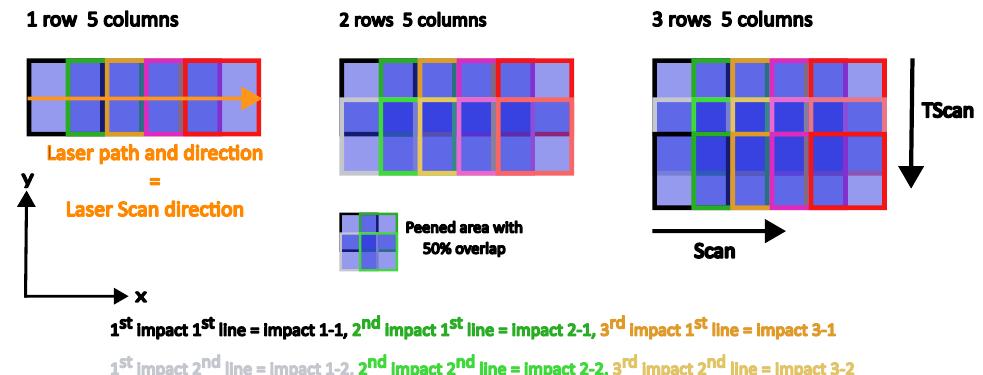
Figure 2. Principle laser path, direction and overlapping of peened area.